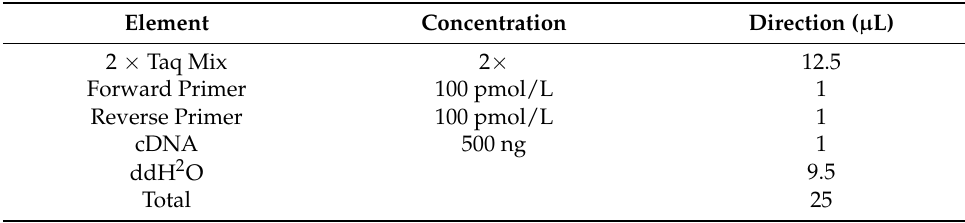
Table 2. The composition of PCR.